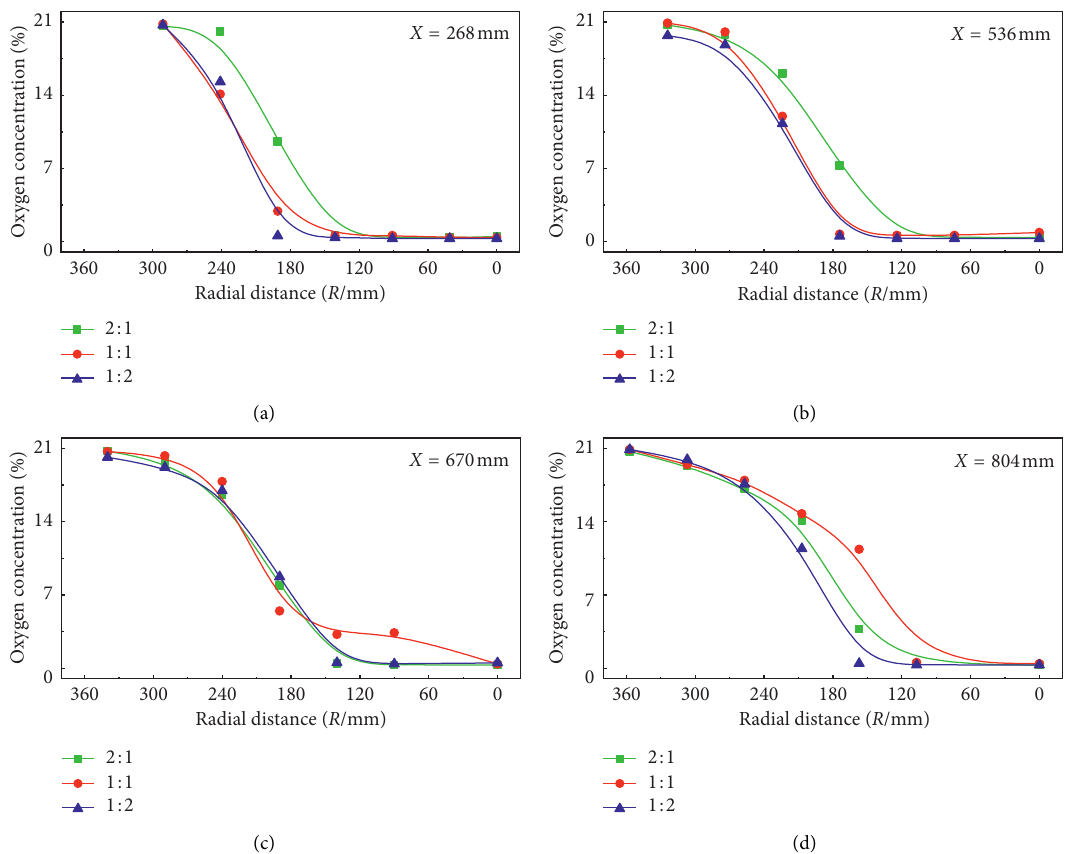
Figure 5: O 2 concentration profiles along radial distance for different ISA/OSA. (a) X X �